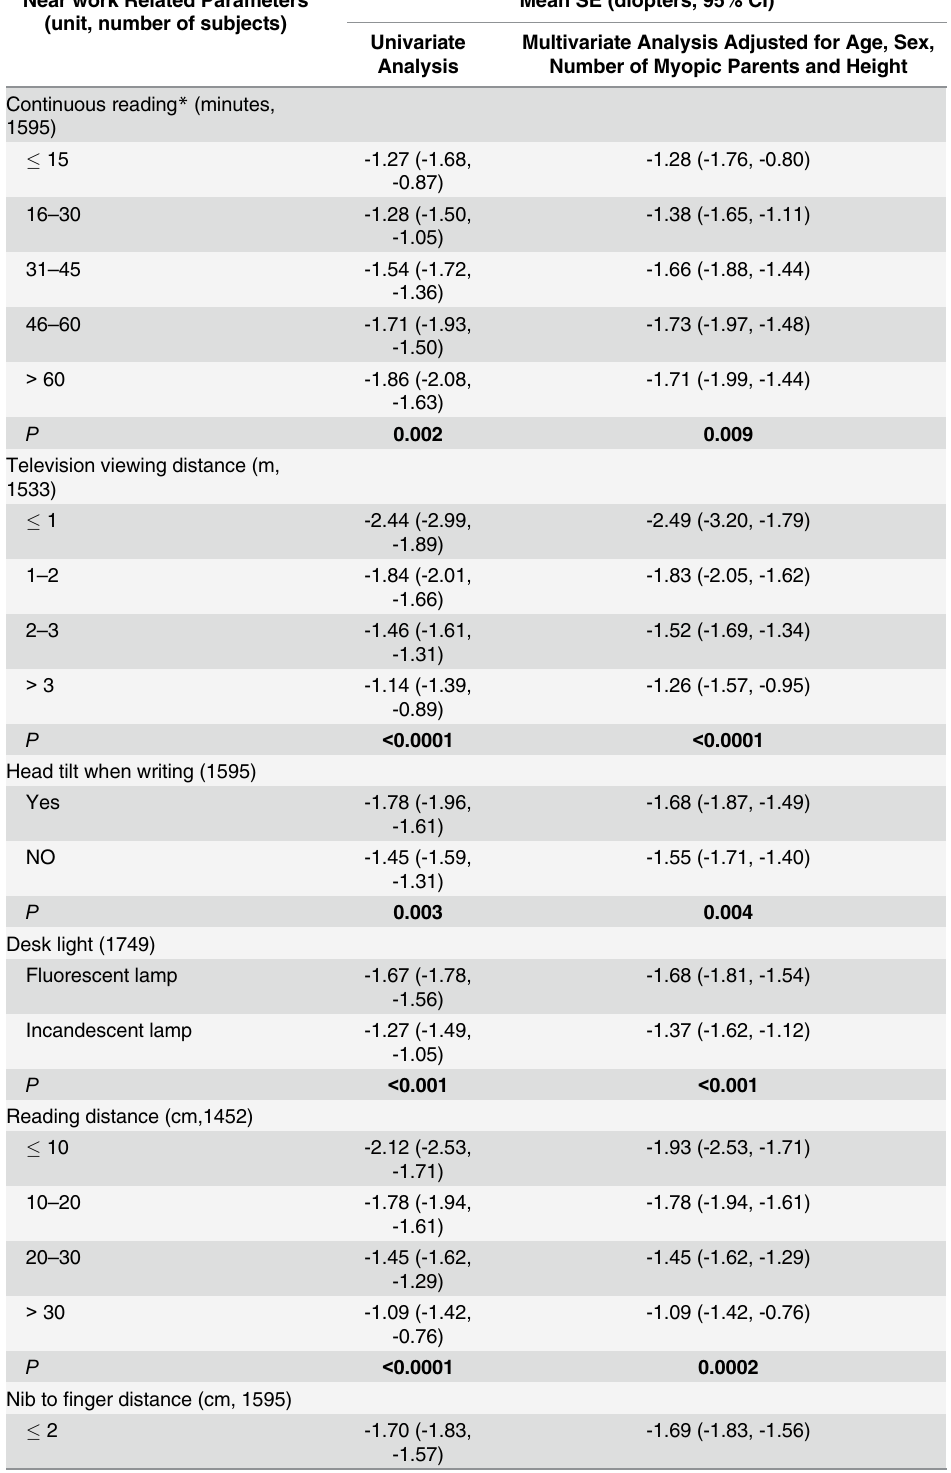
Table 3. Associations of Near work Related Parameters with